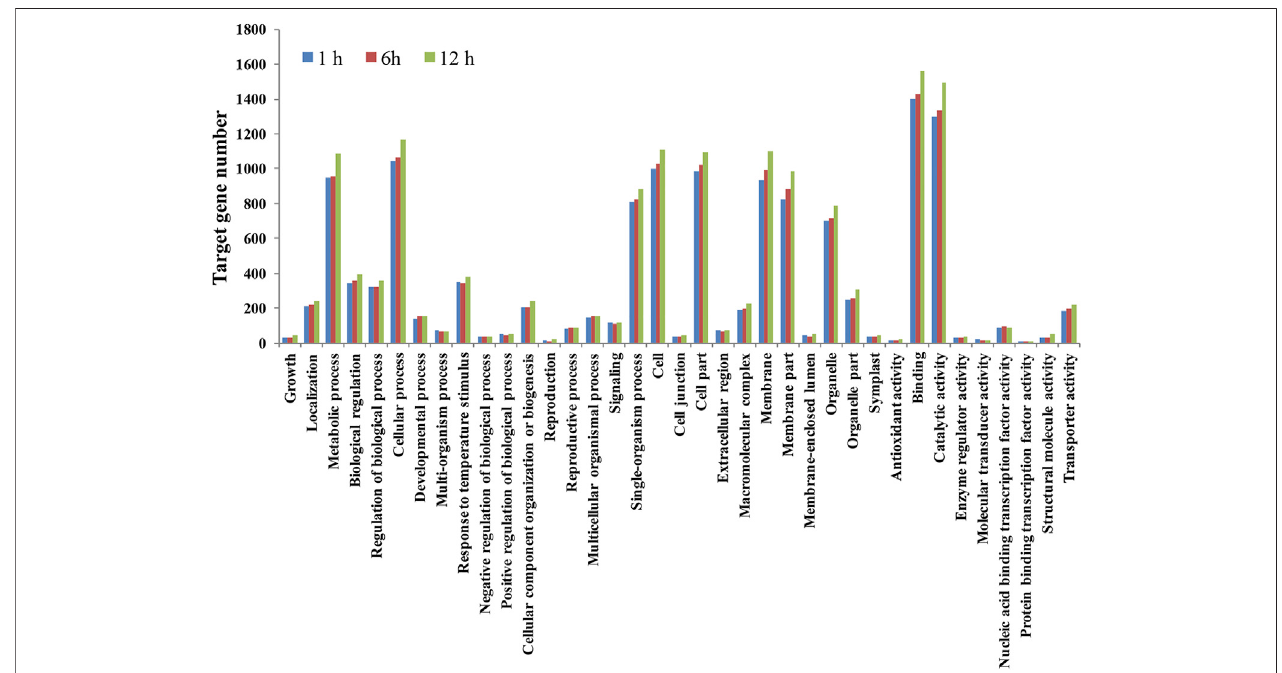
FIGURE 6 | Gene ontology analysis of predicted target genes of heat-stress responsive siRNAs in fl owering Chinese cabbage libraries.